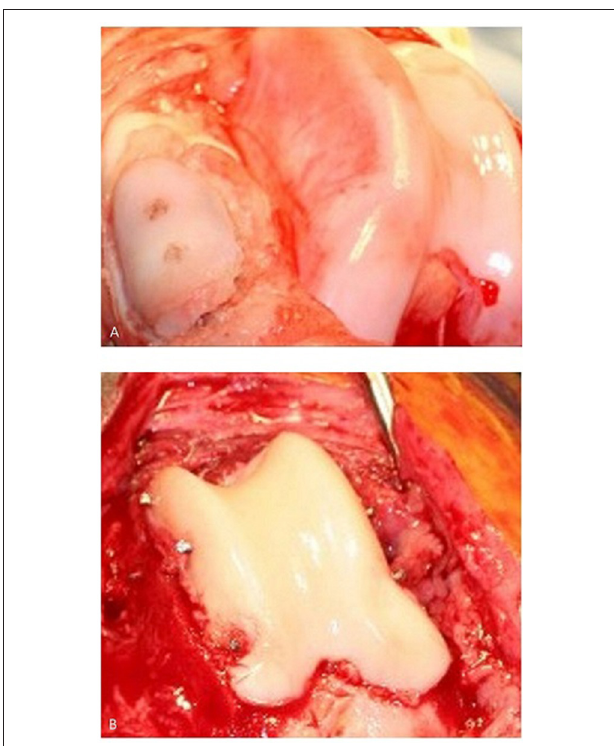
FIGURE 4 | (A) Canine patella resurfacing (image is showing patella resurfacing technique in a cadaver) and (B) trochlear re-surfacing of a canine patient. The patient in (B) achieved an acceptable functional